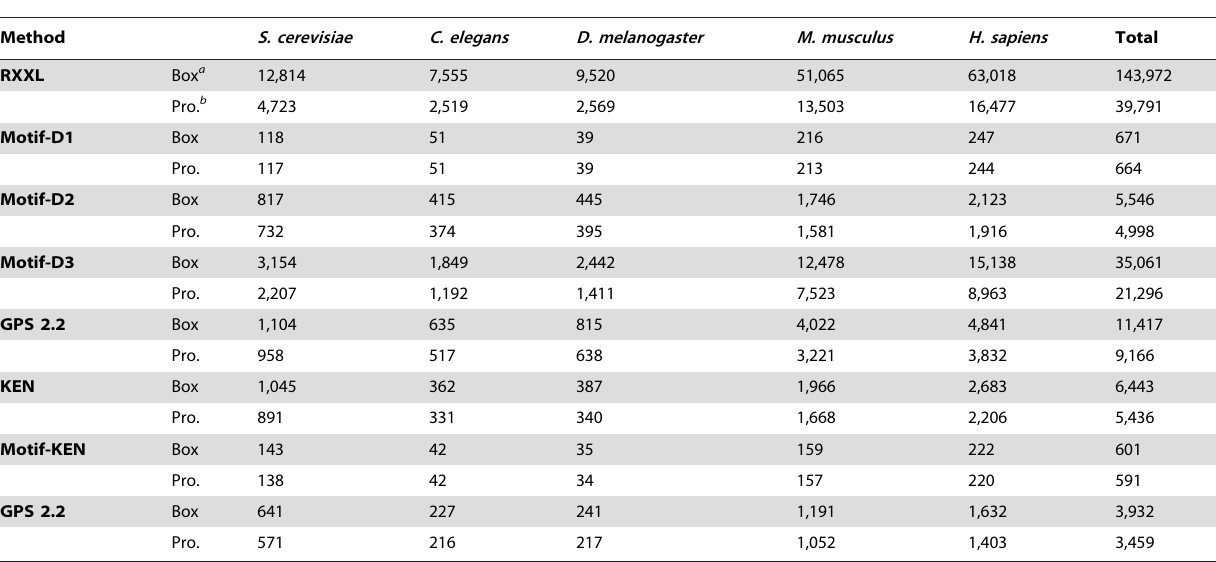
Table 2. The predicted D-boxes and KEN-boxes in five eukaryotic organisms.